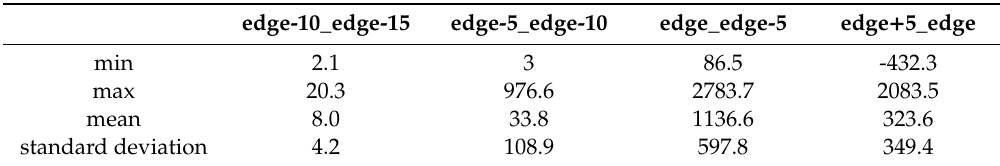
Table 3. Statistics of signal magnitude di ff erence among signal profiles listed in Figure 8. In this table, ‘XXXX_YYYY’ in the first row indicates di ff erence of DN obtained by subtracting DN of YYYY from DN of